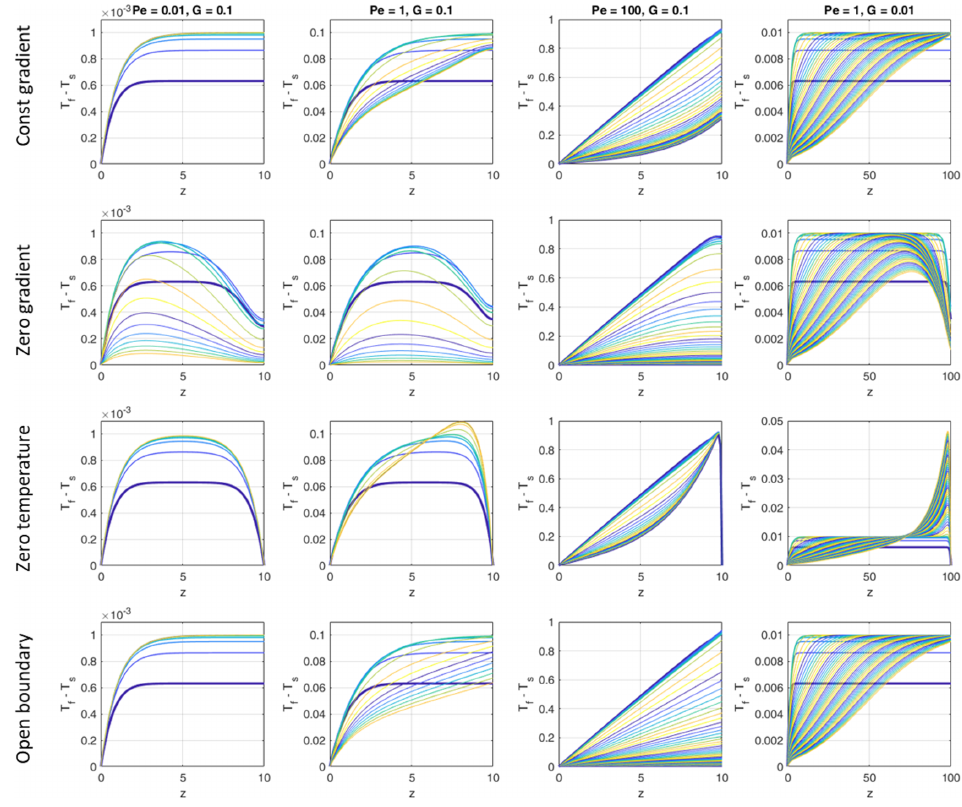
Figure 6. Temporal evolution of vertical profiles of (T f − T s ) for models with different Péclet numbers and different initial temperature gradients G . In each panel the curves show (T f − T s ) profiles for progressive times, and the colors are cyclically varied with time from blue to yellow, starting with blue (bold curve). The first five curves of the Pe < 100 (respectively Pe = 100) models were taken with time increments of 1 (respectively 0.1) and the later curves with 10 (respectively 1). The total time was 100 in all models with G = 0 . 1 and 500 in the models with G = 0 . 01. Steady state is reached in the models with G = 0 . 1. The models with G = 0 . 01 would need t = 10000 to reach steady state. In each row the top boundary conditions are assumed as indicated at the left.